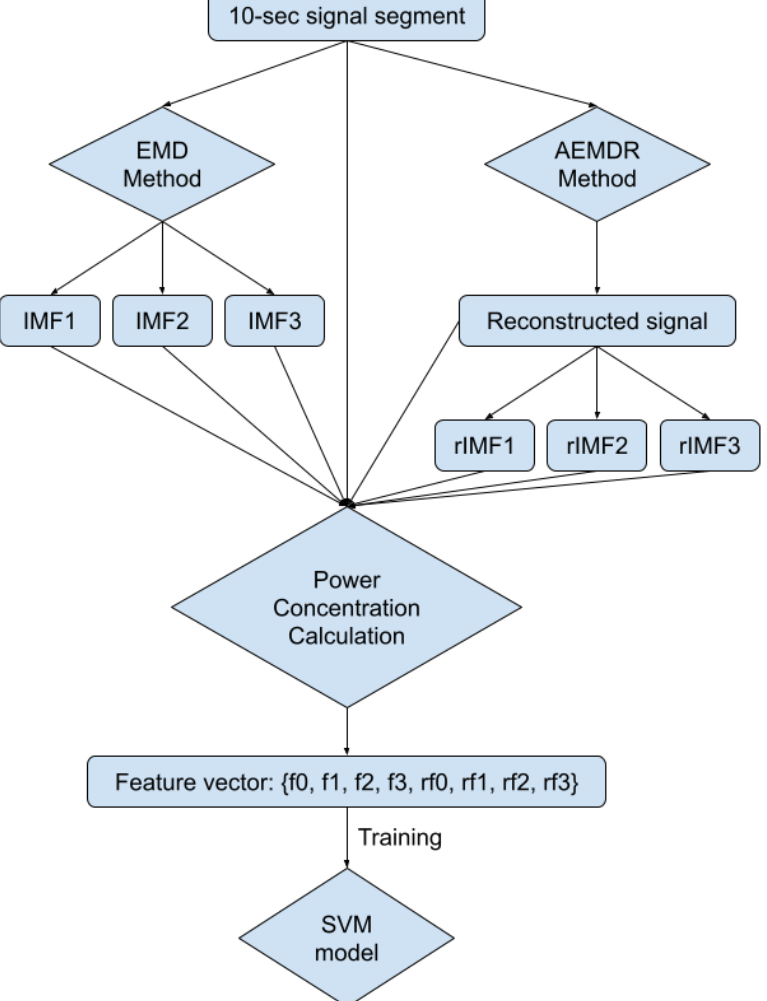
Figure 7. Block diagram of feature extraction and the SVM model training